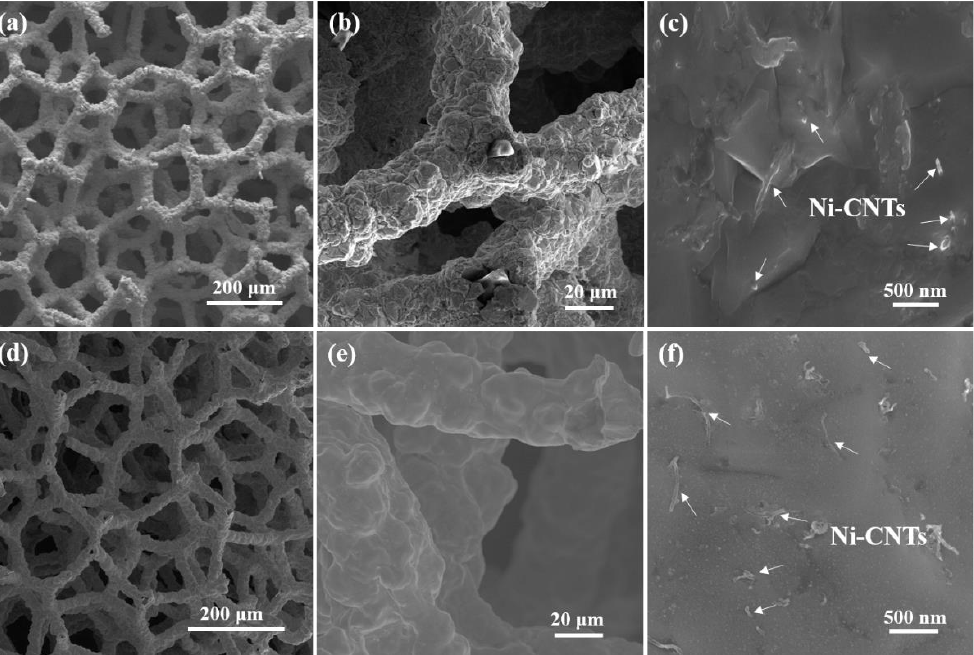
Figure 3. SEM images of Ni-CNTs/Cu foam before and after heat treatment at different magnifica- tions; ( a – c ) before heat treatments; ( d – f ) after heat treatments.